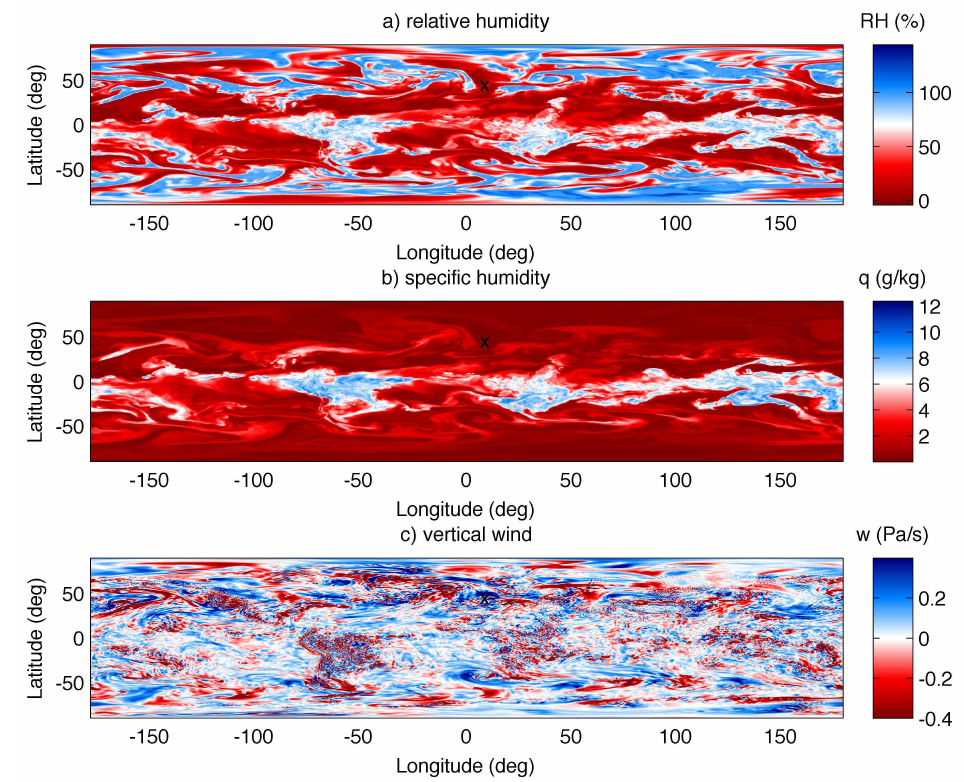
Figure 6. ERA5 global distribution of relative humidity, specific humidity, and vertical wind at 650 hPa on 13 February 2021 20:00 UT. The black X indicates the location of Bern.